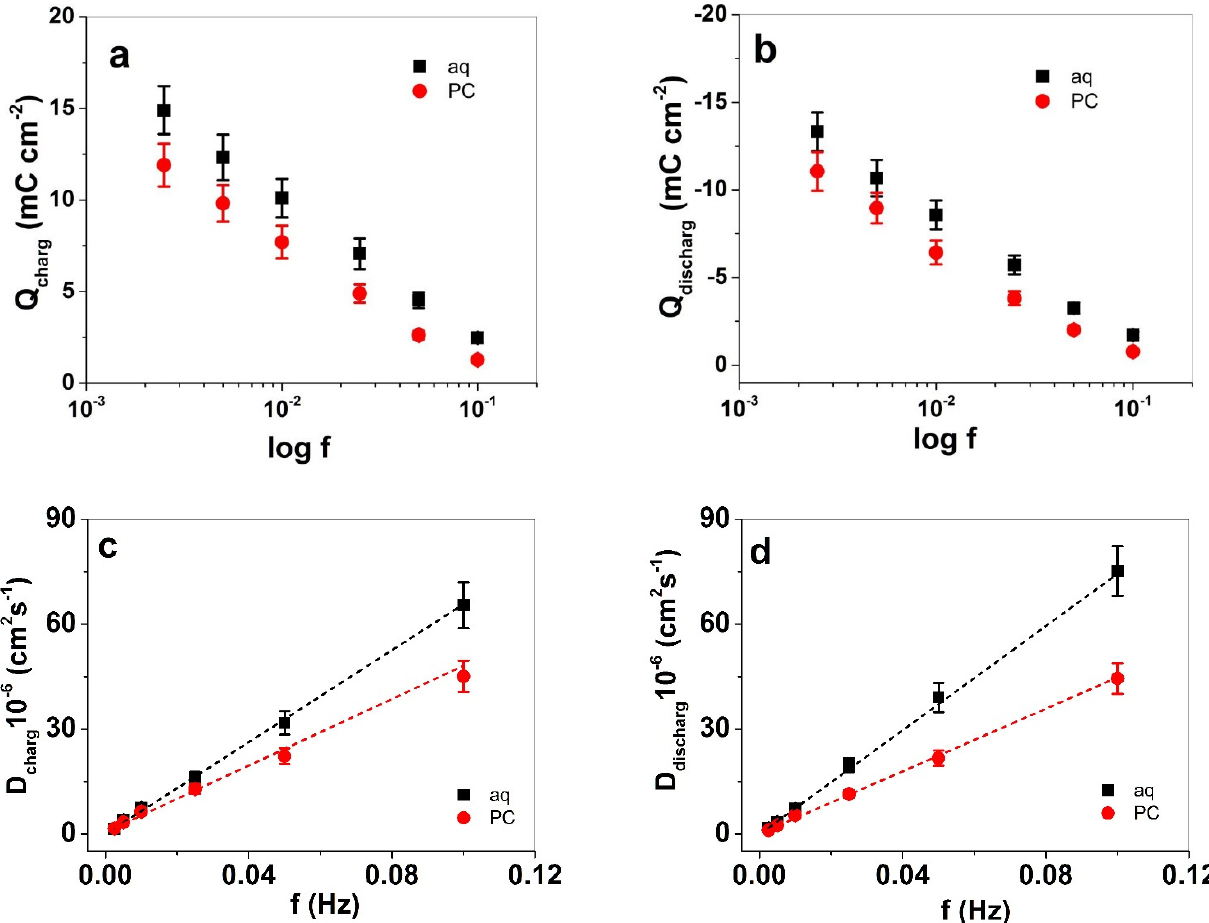
Figure 4. Square potential steps analysis of PIL films in LiTFSI-aq (aq, (cid:4) ) and LiTFSI-PC (PC, • ) at applied potential range 0.65 V to − 0.6 V, and applied frequencies from 0.0025 Hz to 0.1 Hz. ( a ) Charge densities at charging Q charg , ( b ) charge densities at discharging Q discharg against logarithmic scale of frequencies f, ( c ) diffusion coefficients at charging, D charg , and ( d ) at discharging D discharg against applied frequencies f. The dashed black and red lines refer to the linear fit shown here only for